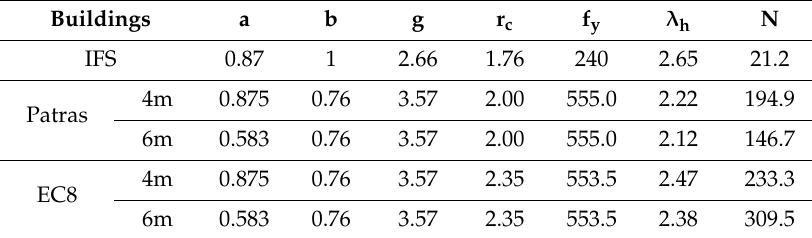
Table 12. Input data for neural network processing.